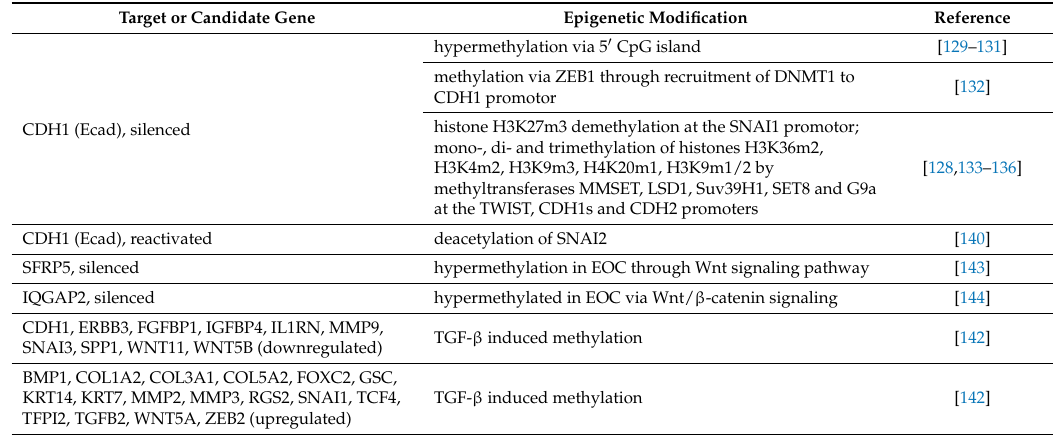
Table 1. Target and candidate genes with EMT-associated epigenetic